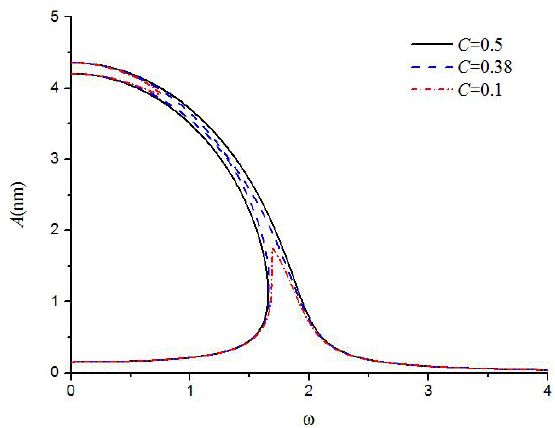
Fig. 3. The effect of damping factor to the amplitude-frequency re- sponse